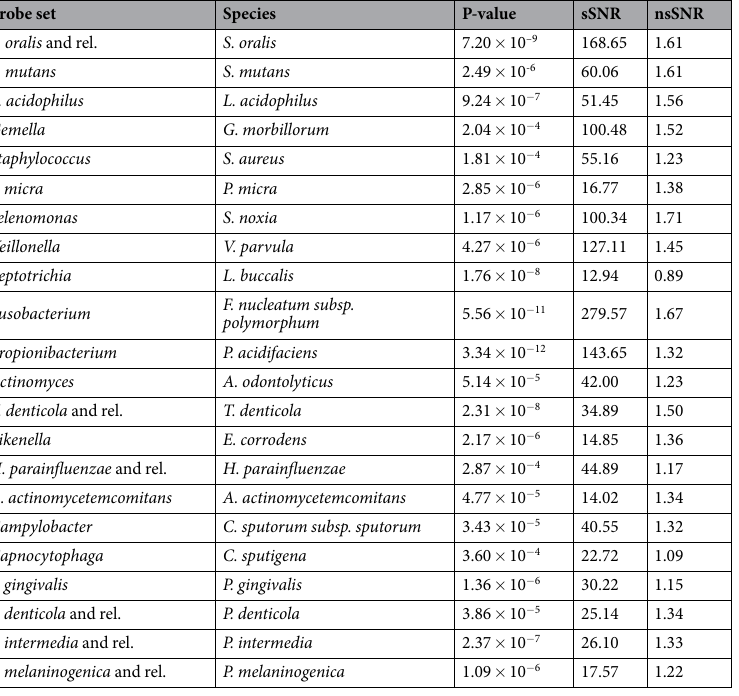
Table 2. Bacterial species used for specificity tests, P-values, probe specific (sSNR) and not specific (nsSNR) signal-to-noise